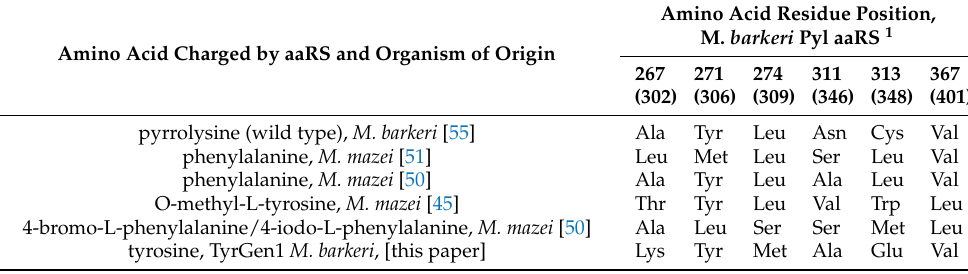
Table 1. Comparison of the identity of amino acids at 6 positions in the amino acid-binding pocket for Methanosarcina sp. Pyl aminoacyl tRNA synthetases capable of activating aromatic amino acids.